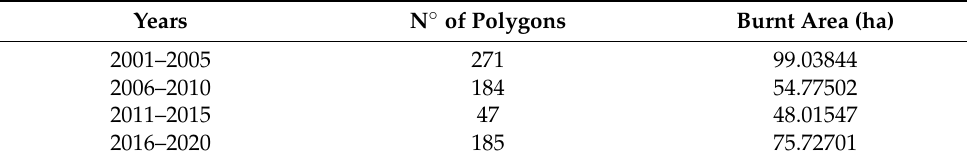
Table 6. Number and burnt area of LW ( ≥ 100 ha) in Portugal mainland.